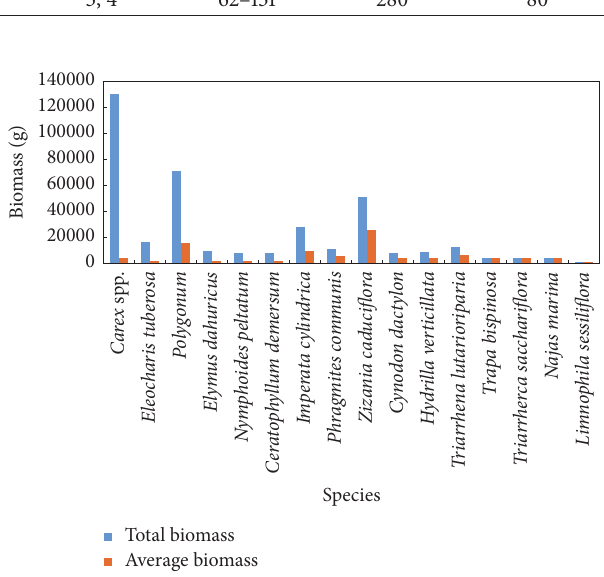
Figure 2: The total biomass and average biomass of the typical aquatic macrophyte’s association types in the Poyang